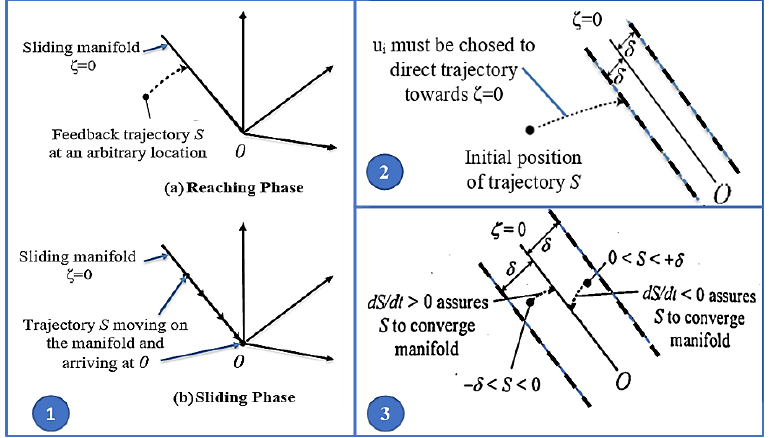
Figure 3. The two-DGs-based adopted MG system.